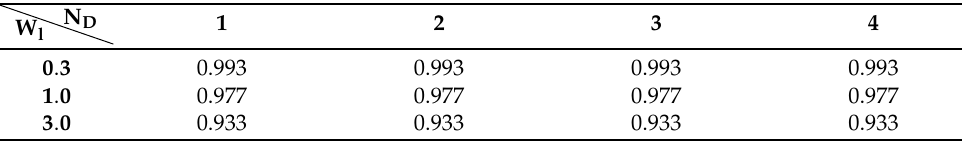
Table 3. Probability to find a CS slot free ( P s − CS ).